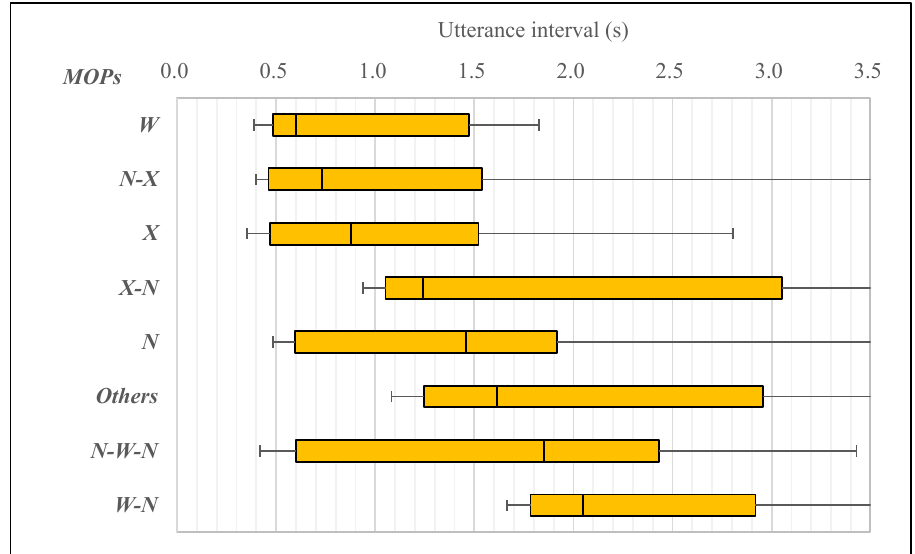
Figure 9. Box plot of utterance interval for each MOTP of listeners during